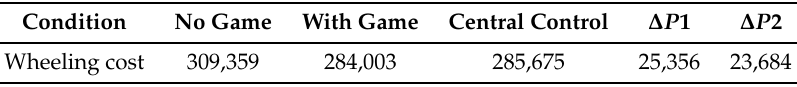
Table 2. Daily wheeling cost under different condition